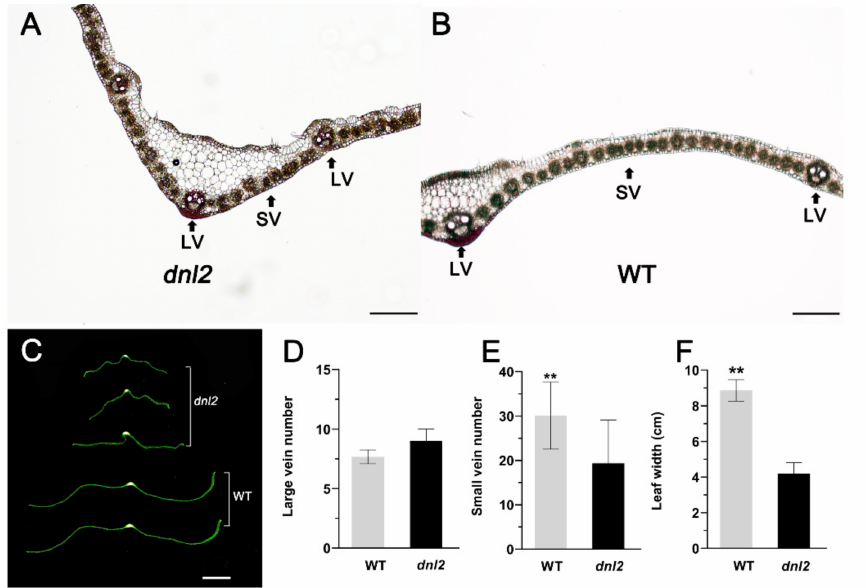
Figure 5. Comparison of the transverse sections of the leaves of dnl2 and the wild-type at the mature stage. ( A , B ) Anatomical analysis of the transverse sections of dnl2 and the wild-type leaves by microscope. Bar = 500 µ m. LV: large vein; SV: small vein. ( C ) Transverse sections of the leaves of dnl2 and the wild-type. Bar = 1 cm. ( D ) Large vein number of dnl2 and the wild-type. ( E ) Small vein number of dnl2 and the wild-type. ( F ) Leaf width of dnl2 and the wild-type. Asterisks indicate significant differences between dnl2 and the wild-type (** p <